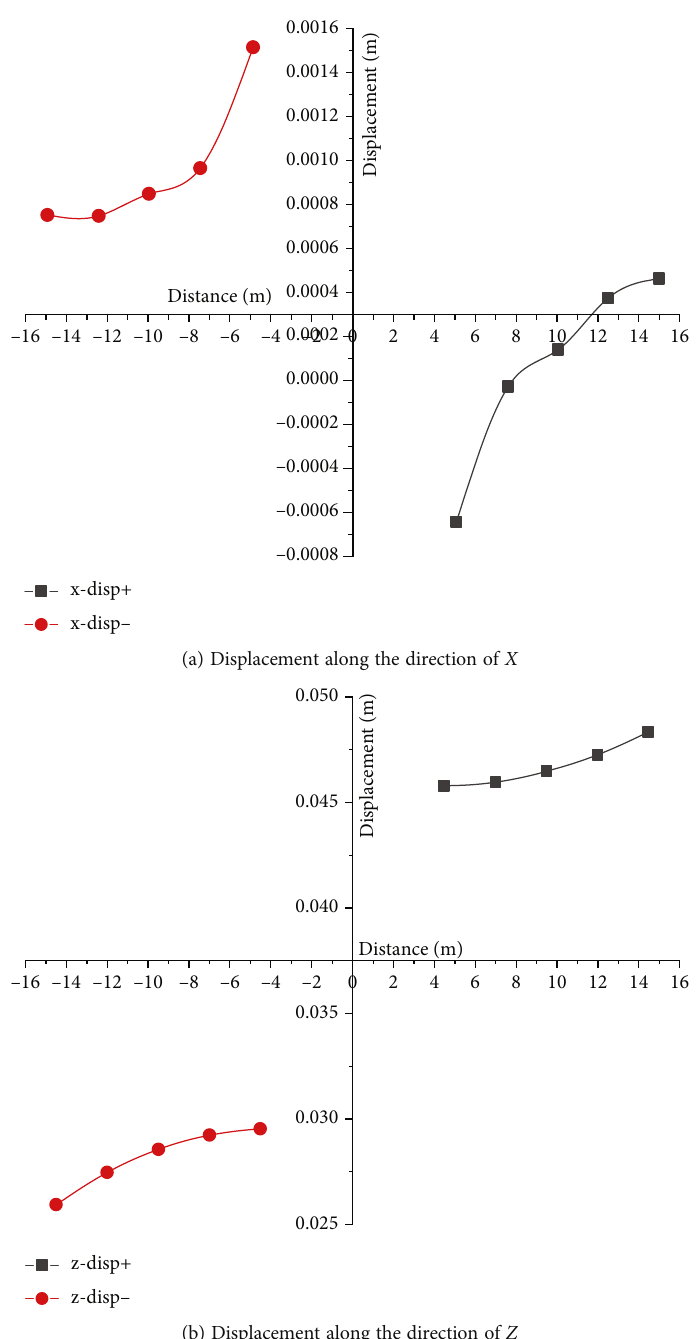
Figure 7: Displacement curve of the